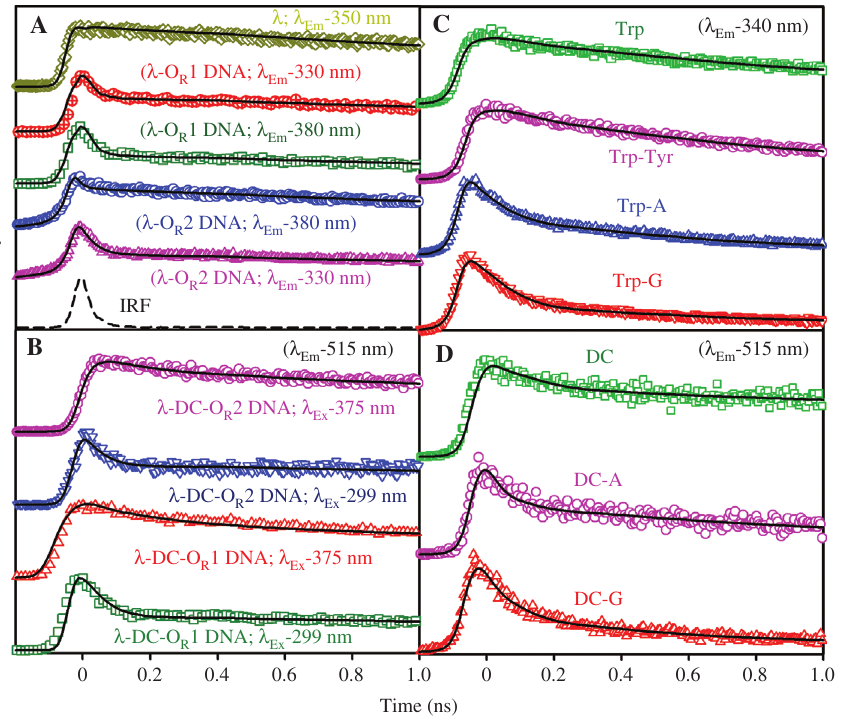
Figure 20 Excited state charge transfer in operator-repressor